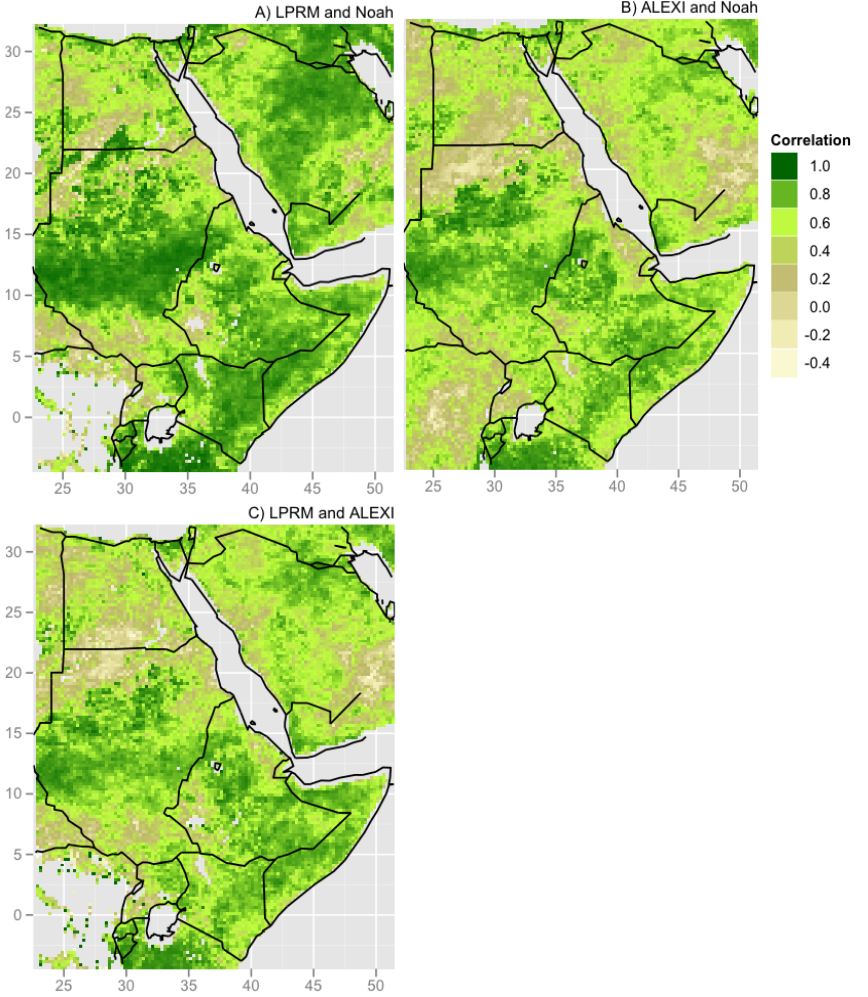
Fig. 5. Temporal cross-correlation of rescaled soil moisture anomalies for January 2007–June 2010 computed between (A) LPRM and Noah, (B) ALEXI and Noah, and (C) ALEXI and